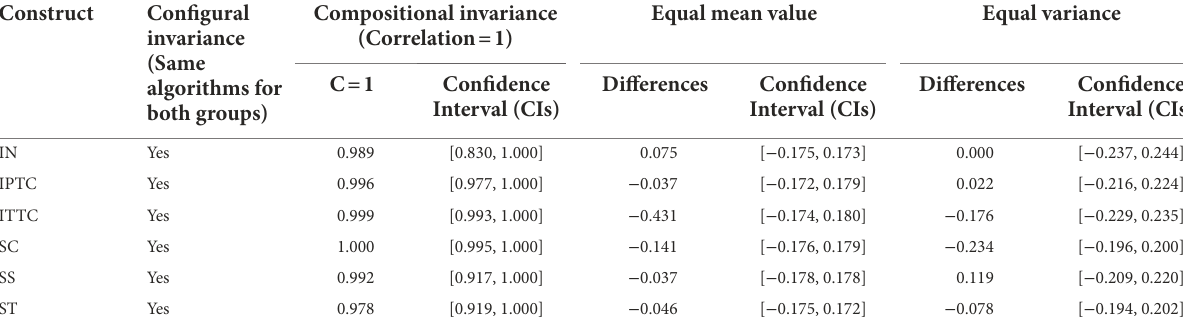
TABLE 8 Results of invariance measurement testing using permutation.